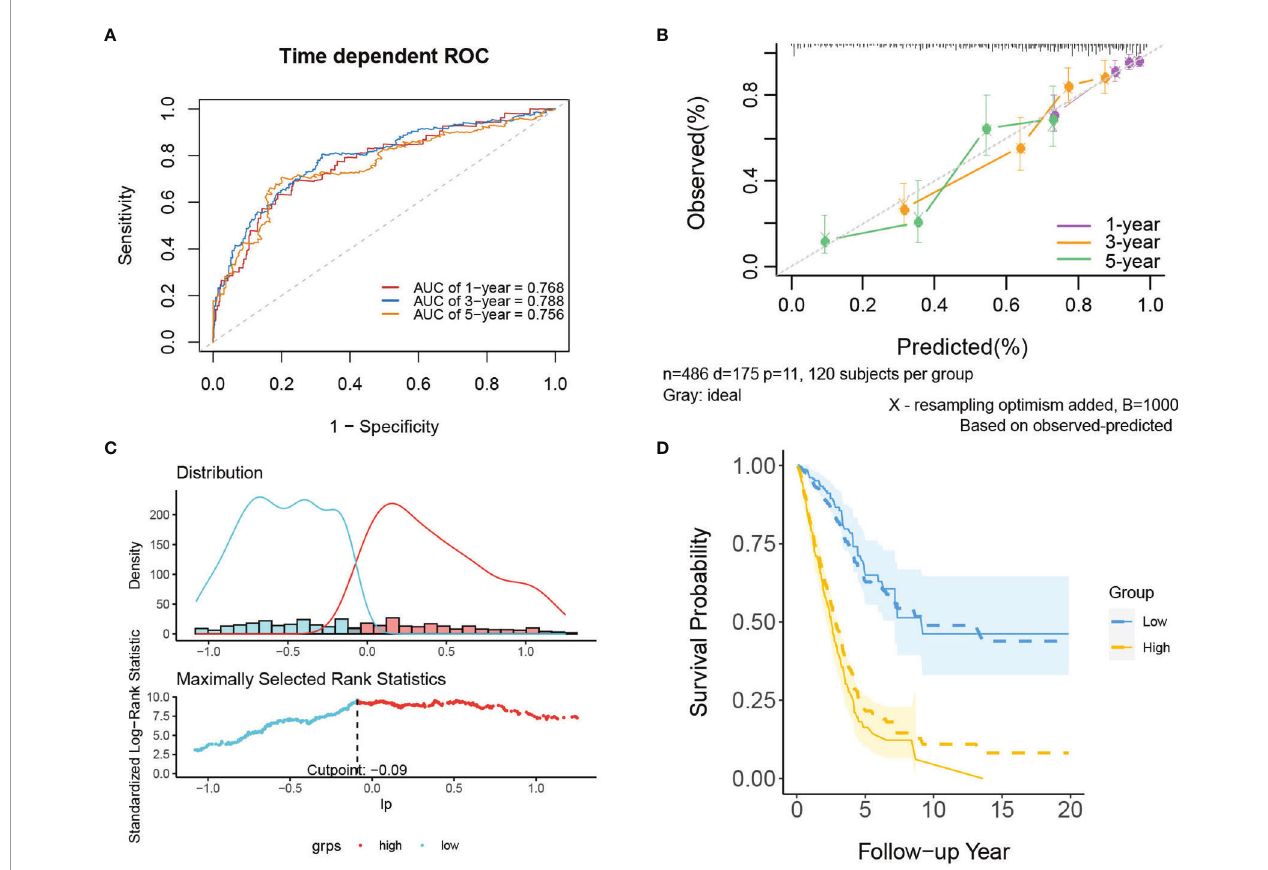
FIGURE 4 | The performance of the mRNA model in the derivation dataset. (A) 1-,3-,5-year ROC curves and (B) calibration plot of the mRNA model. (C) The optimal cutoff value of PI. (D) Predicted versus observed survival probability in per risk group. Solid line: observed Kaplan-Meier curve; dotted line: average predicted survival curve; shaded area: 95% con fi dence interval of observed survival